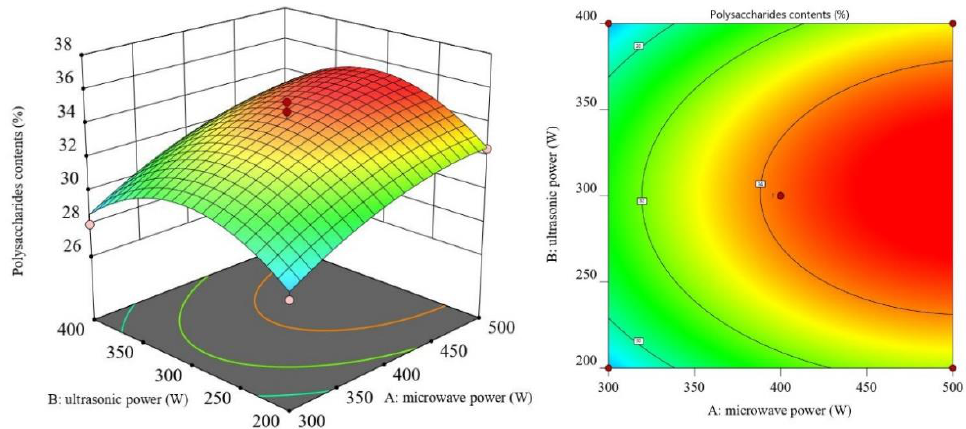
Figure 3. Effect of the interaction of ultrasonic and microwave power on polysaccharide yield. (A is the microwave power/(W), B is the ultrasonic power/(W)).